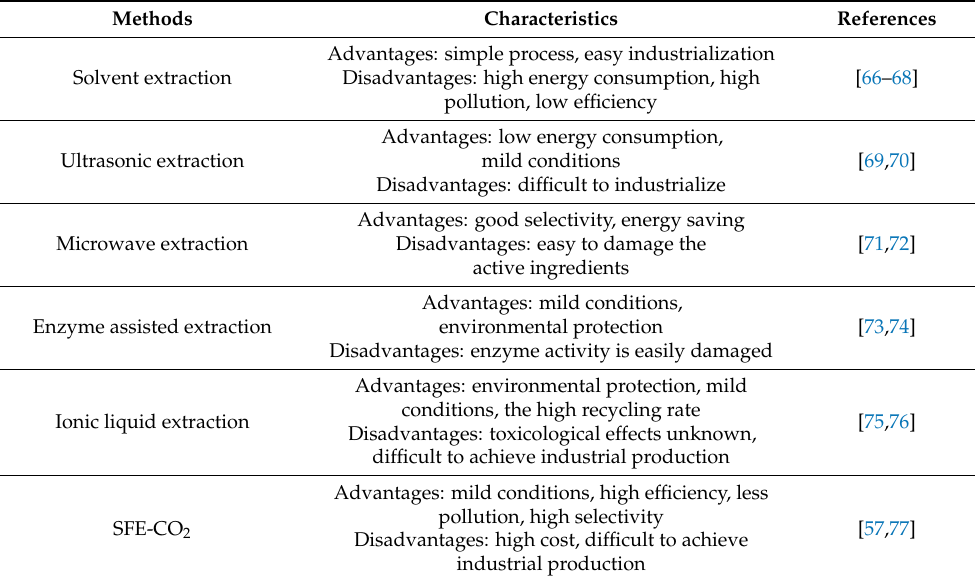
Table 1. The extraction methods and characteristics of active components from Ginkgo biloba